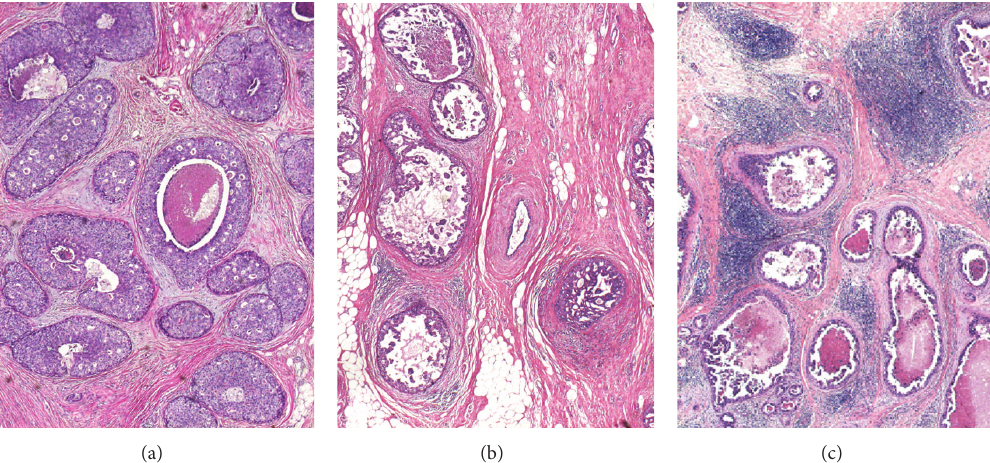
Figure 2: Lymphocytic infiltration. Hematoxylin-eosin stain; microscopic magnification 40 × . (a) No periductal lymphocytic infiltration; (b) mild periductal lymphocytic infiltration; (c) intense periductal lymphocytic